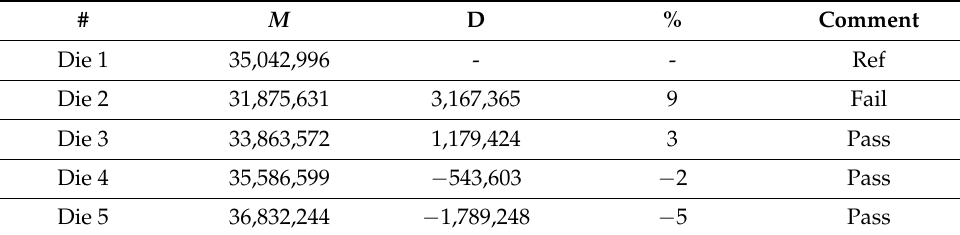
Figure 6. ( a ) Close up of the scanned profile of 5 consecutive dies extracted from Figure 5a. Profile detail of individual dies is visible. ( b ) Profile obtained via a graphical analysis of 5 consecutive dies from Figure 5a. The blue bars correspond to the groove positions for slicing. Table 1. Criterion example